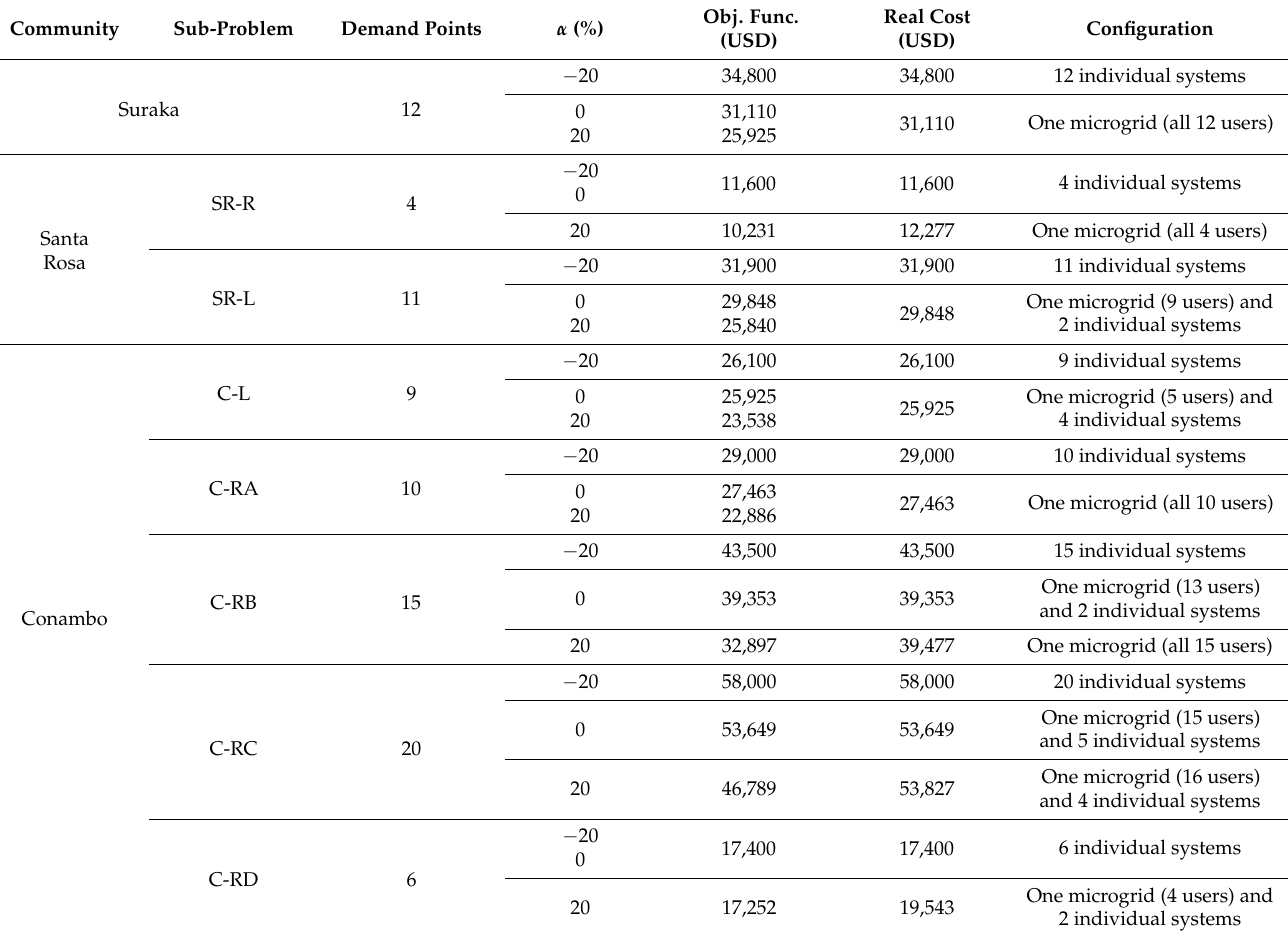
Table 5. Solutions obtained for the three